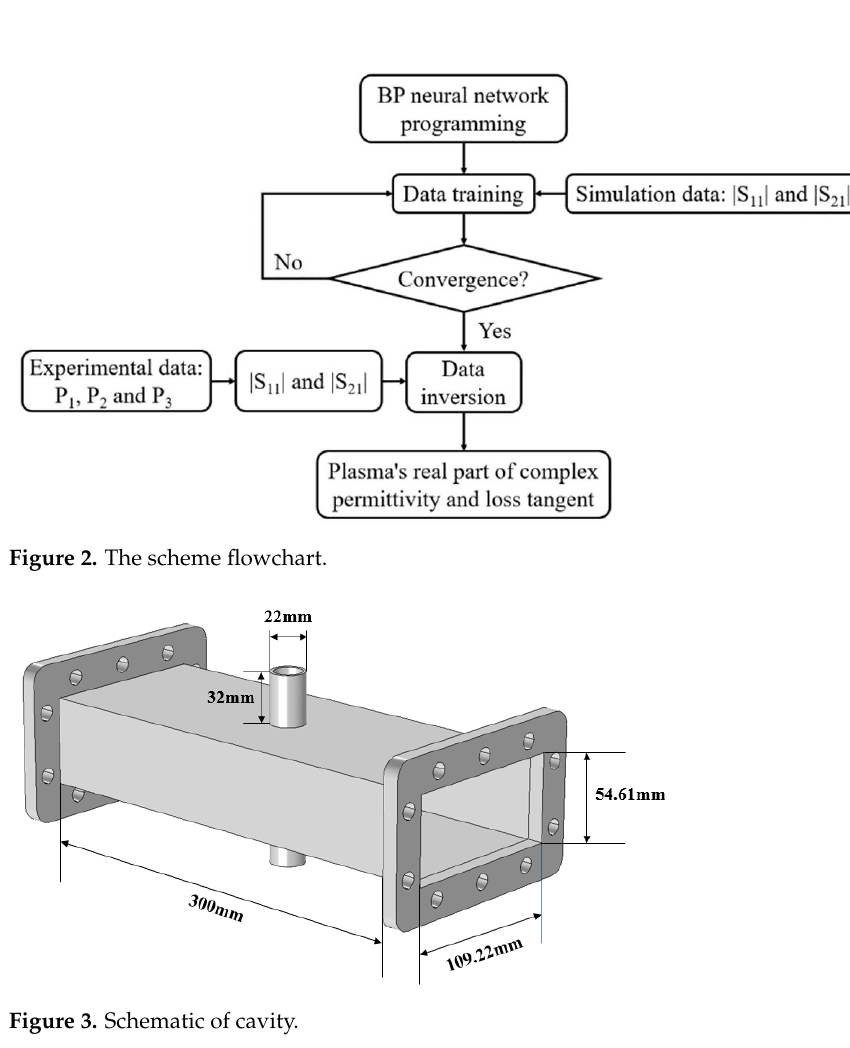
Figure 3. Schematic of cavity.